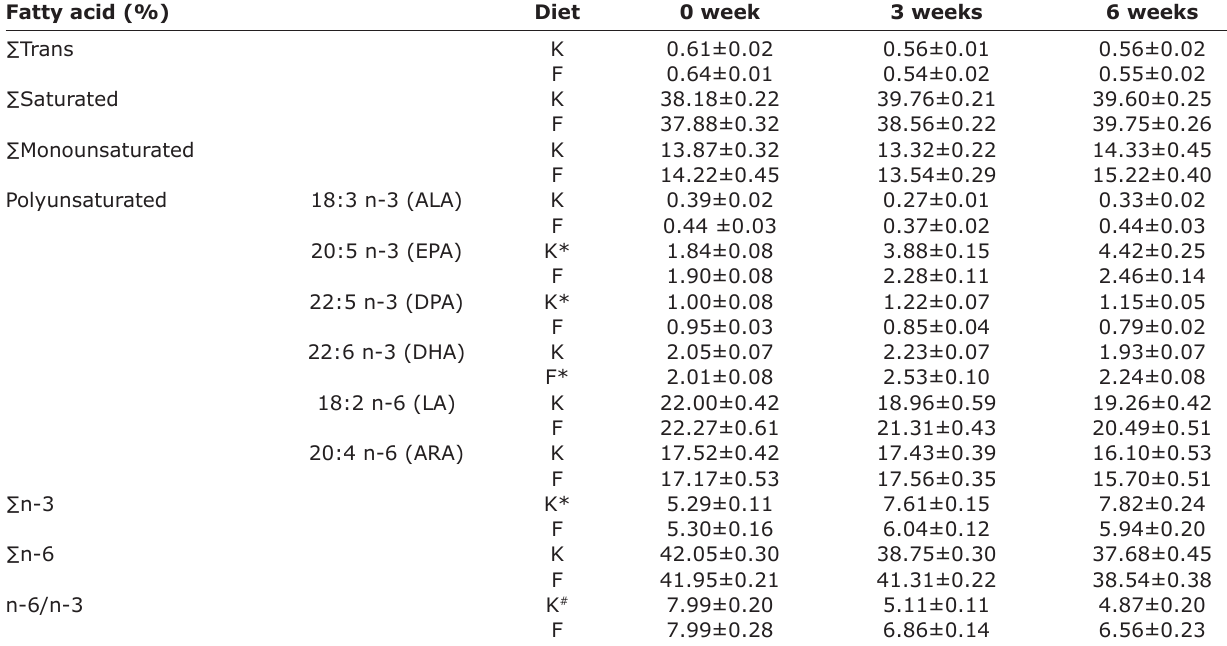
Table-2: Mean (±SE) fatty acid composition of RBC membranes (%) across the study period by supplement type (K, krill meal, and F, fish oil). Fatty acid (%) Diet 0